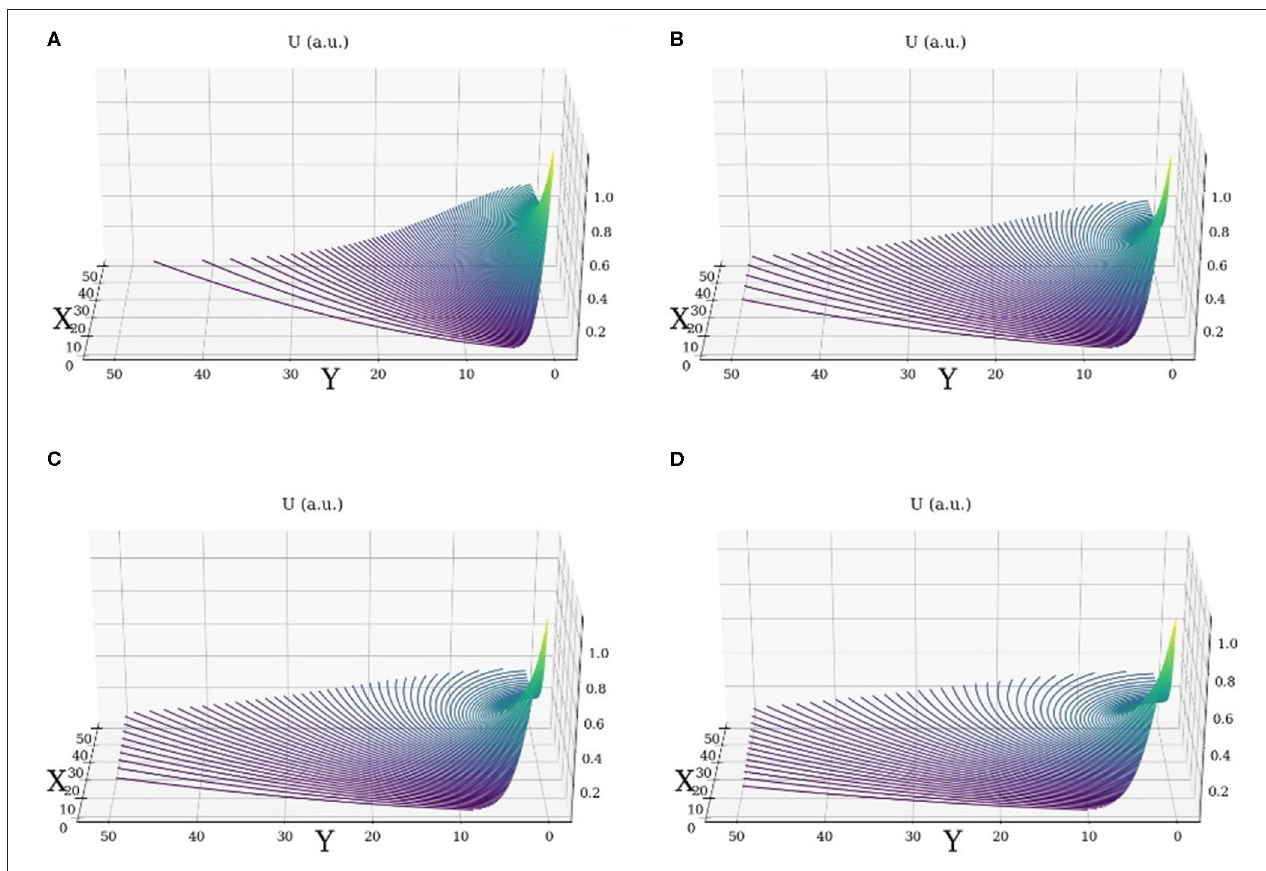
FIGURE 1 | Normalized velocity field U , for θ